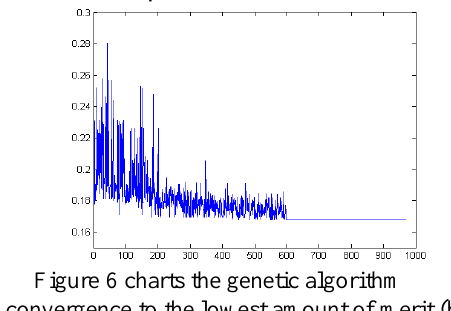
Figure 6 charts the genetic algorithm convergence to the lowest amount of merit (best Kappa coefficient